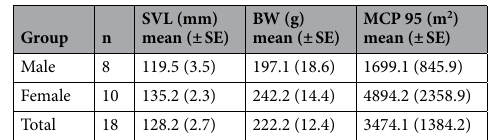
Table 2. Home range of Lithobates catesbeianus in Gimje, South Korea.